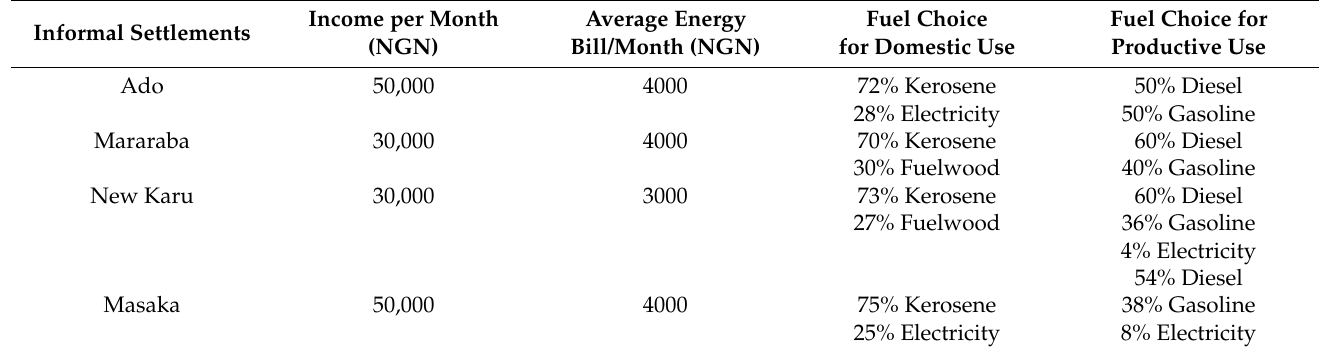
Table 11. Results of the survey of the informal settlements.